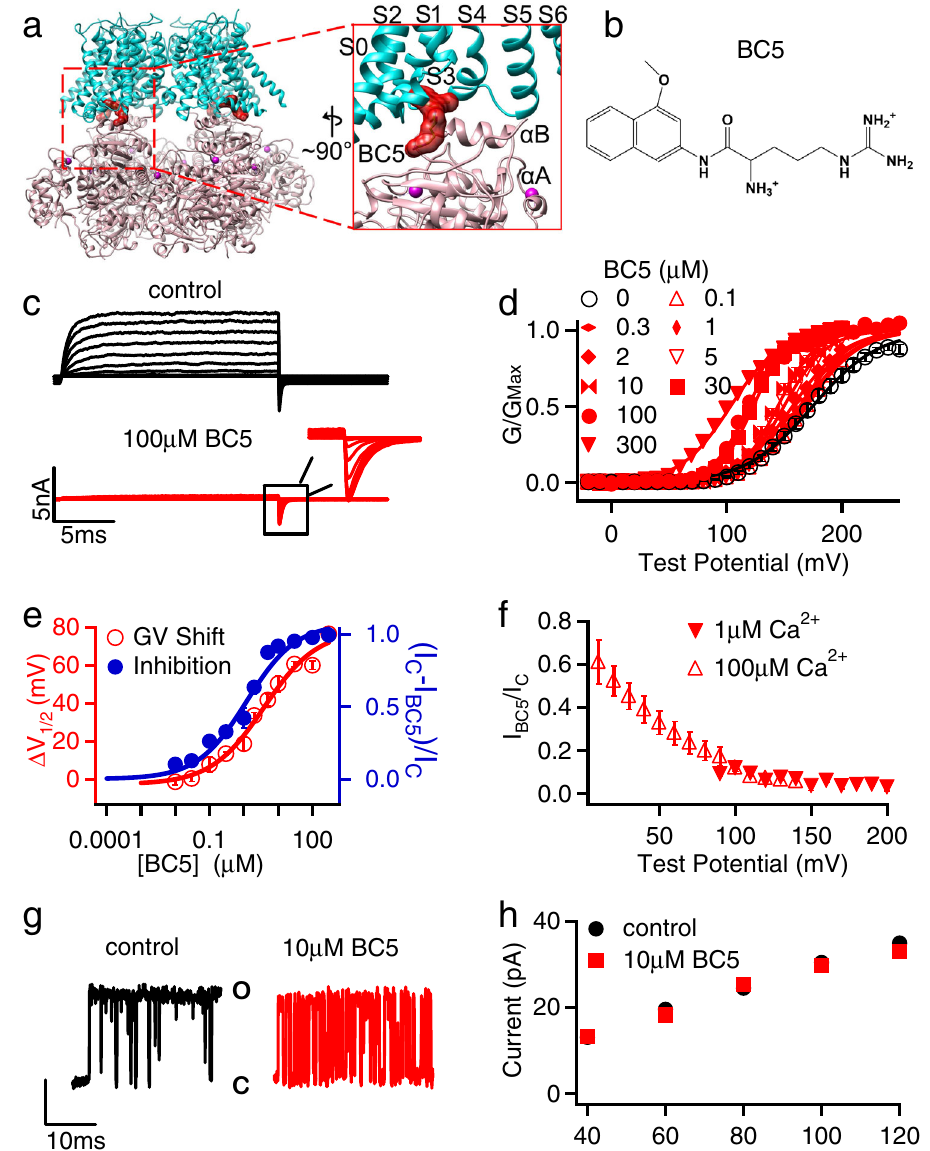
Fig.1|BC5effectsonBKchannels.a hSlo1